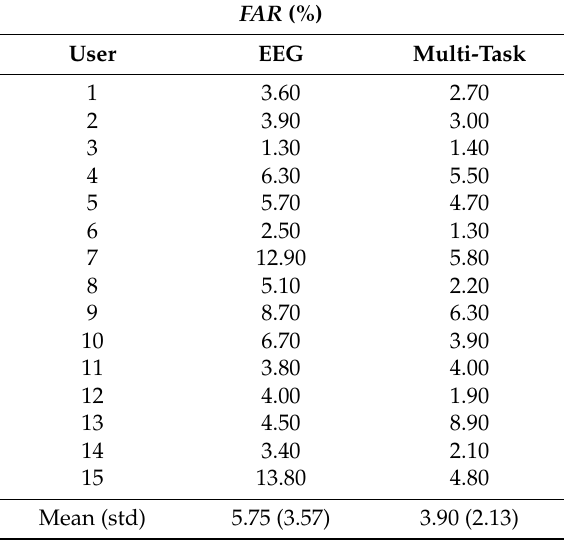
Table 3. The performance of EEG-based and multi-task authentication system in